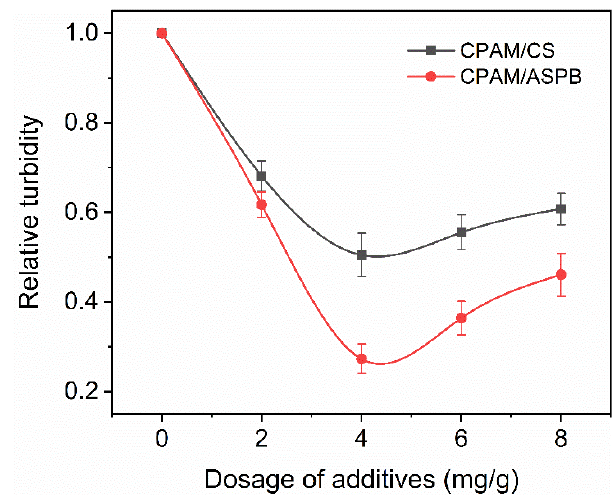
Figure 5. Relative turbidity of pulp in a dual-component system.